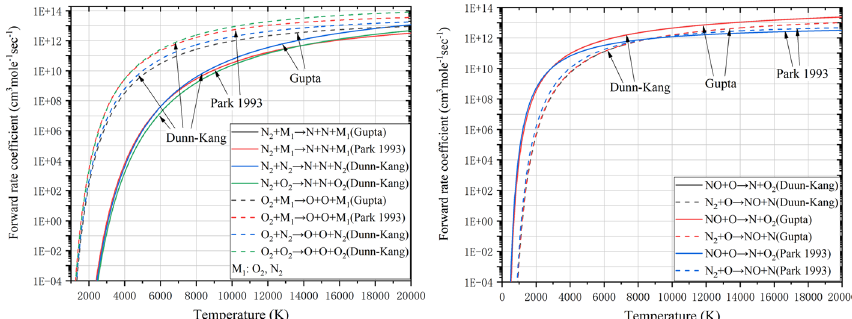
Fig. 6 Forward rate coefficients of the 5-species air of the Dunn–Kang, Park1993, and Gupta models